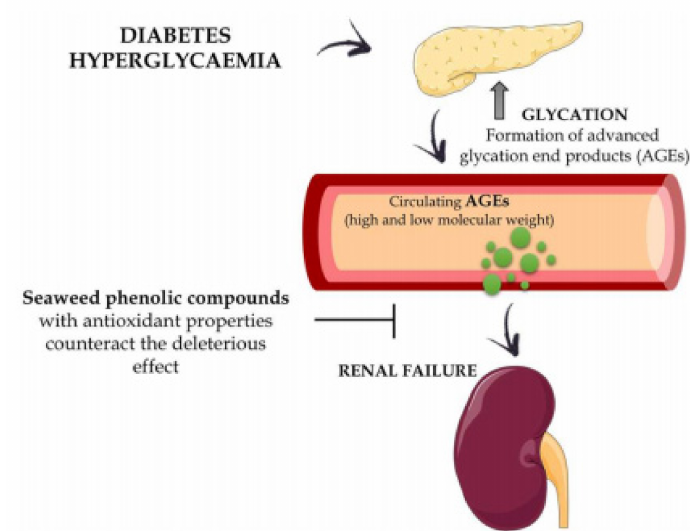
Figure 2. The viral infection stages and the antiviral potency of macroalgal polysaccharides, modified after [21].